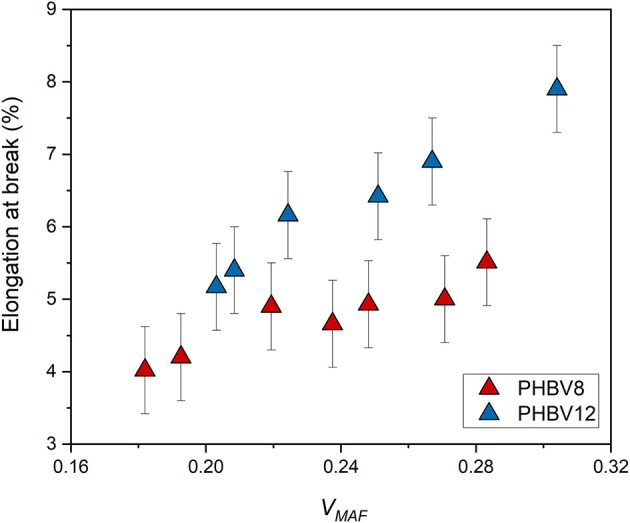
Elongation at break of PHBV8 and PHBV12 after different storage times at Troom, as a function of the mobile amorphous volume fraction VMAF. The bars are the estimated errors.